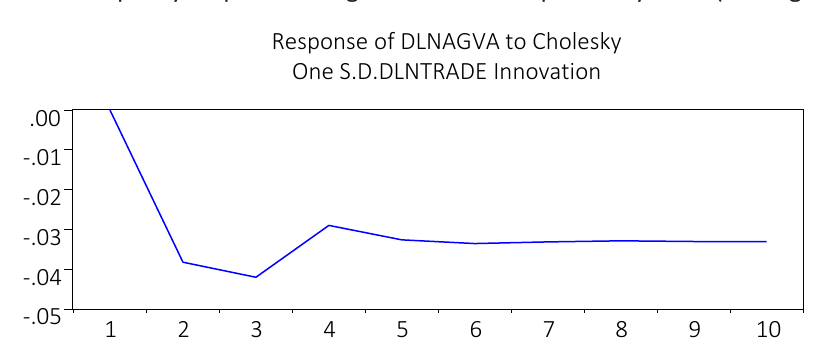
Figure 2b. REC policy response on agricultural development by 2030 (SDG